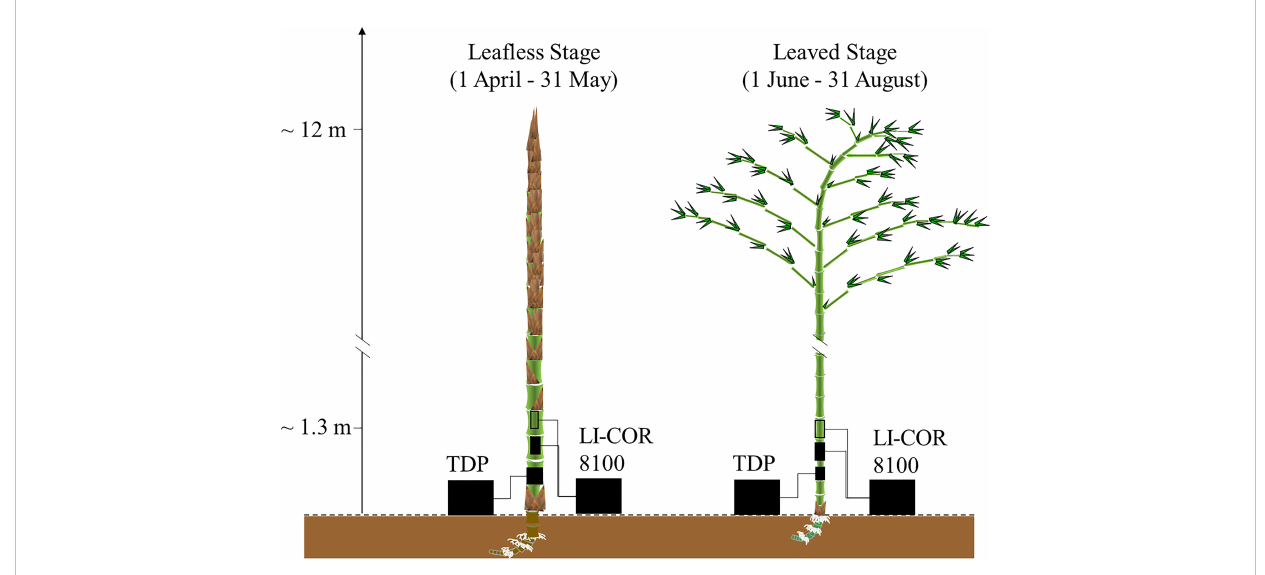
FIGURE 1 Bamboo phenology and experimental design. This study monitored sap fl ow with a self-built thermal dissipation probe based on the classical Granier type (TDP). In addition, CO 2 ef fl ux in the fi eld was measured with LI-COR 8100 (Li-cor Inc., USA) using transparent and light-proof